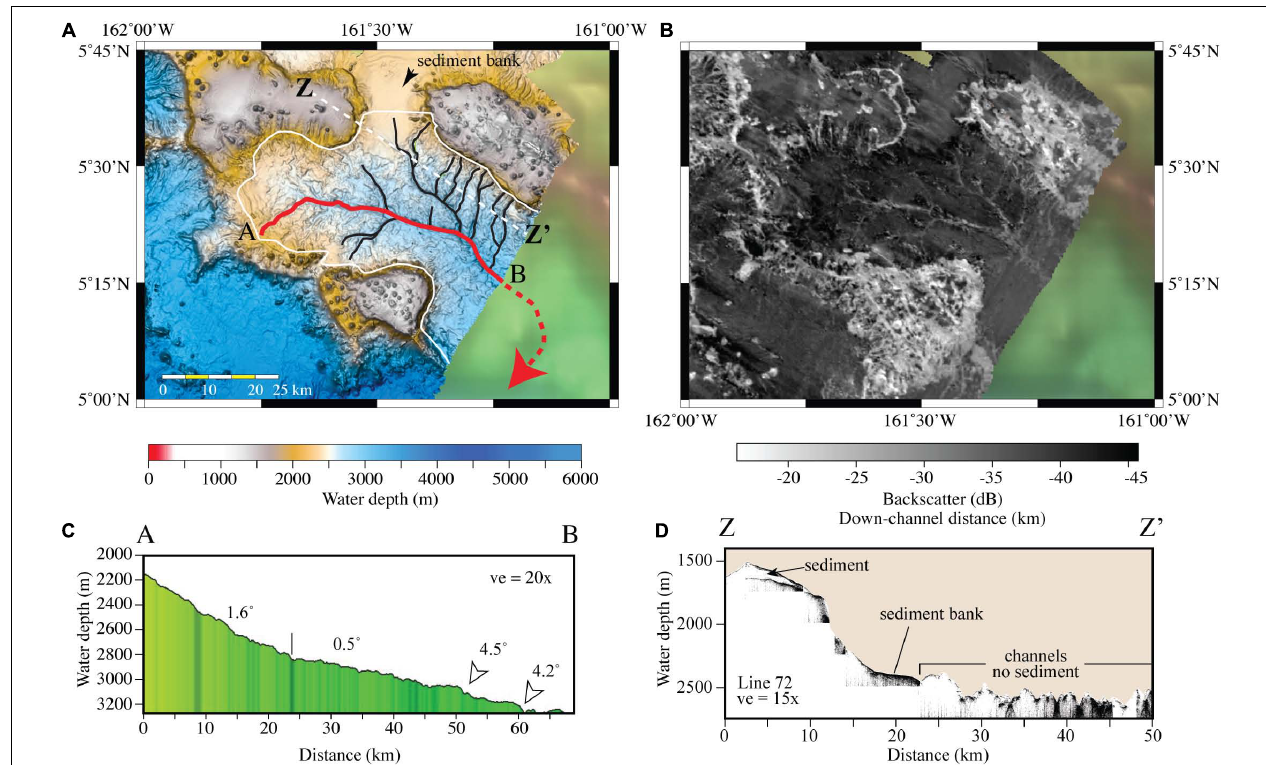
FIGURE 11 | (A) Map view of multibeam bathymetry of channel system CS-D (see Supplementary Figure S8 for same view with no interpretations). Location of CS-D shown on Figure 3 . Drainage area (see text) outlined in solid white line. The main channel is traced as a red line and tributaries in black. (B) Same area as (A) showing acoustic backscatter of CS-D. (C) Profile A-B of the down-channel distance along main channel. White arrowheads point to two significant channel descents. (D) Subbottom seismic line 172 shown in map view as white dashed line